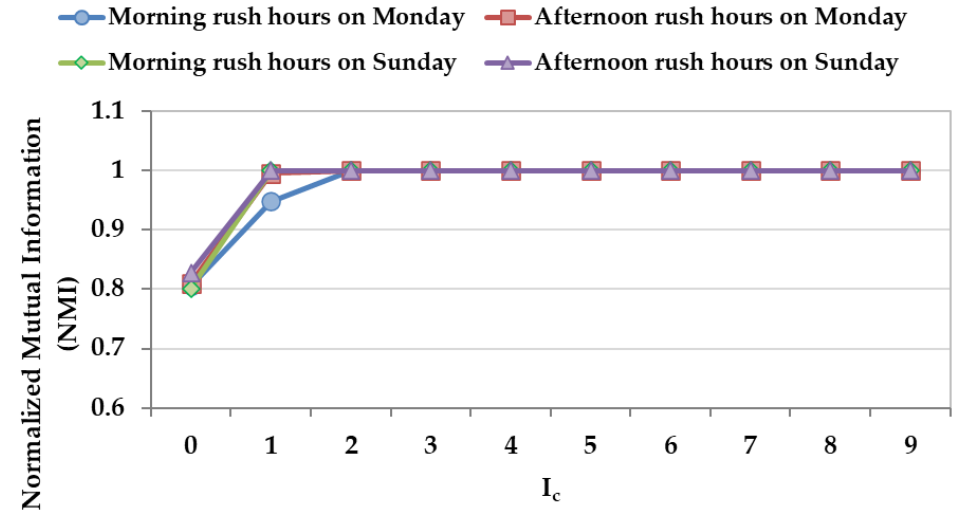
Figure 8. NMI with different iteration times of consensus clustering.